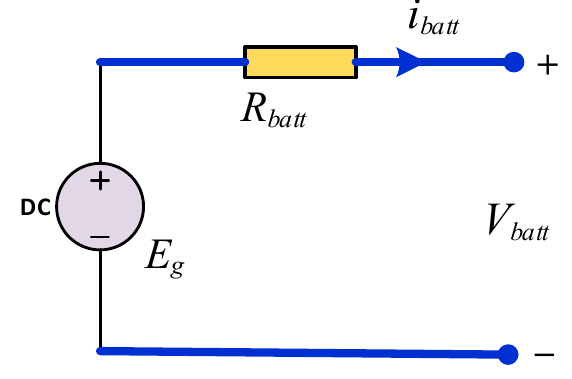
Figure 5. Equivalent circuit of battery. The storage local control unit adjusts battery current to control charge and discharge DC bus voltage remains